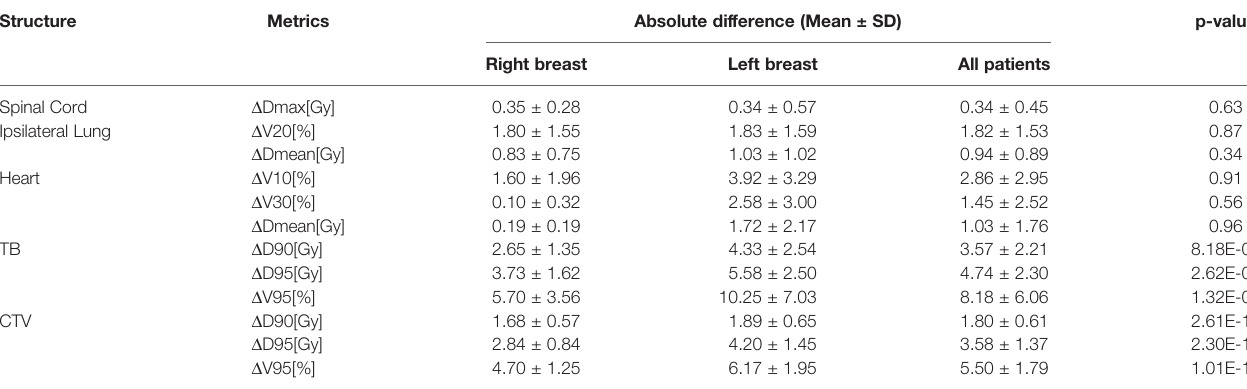
TABLE 5 | Absolute difference of the dosimetric metrics for both plans of 23 patients. Structure Metrics Absolute difference (Mean ± SD) p-value Right breast Left breast All patients Spinal